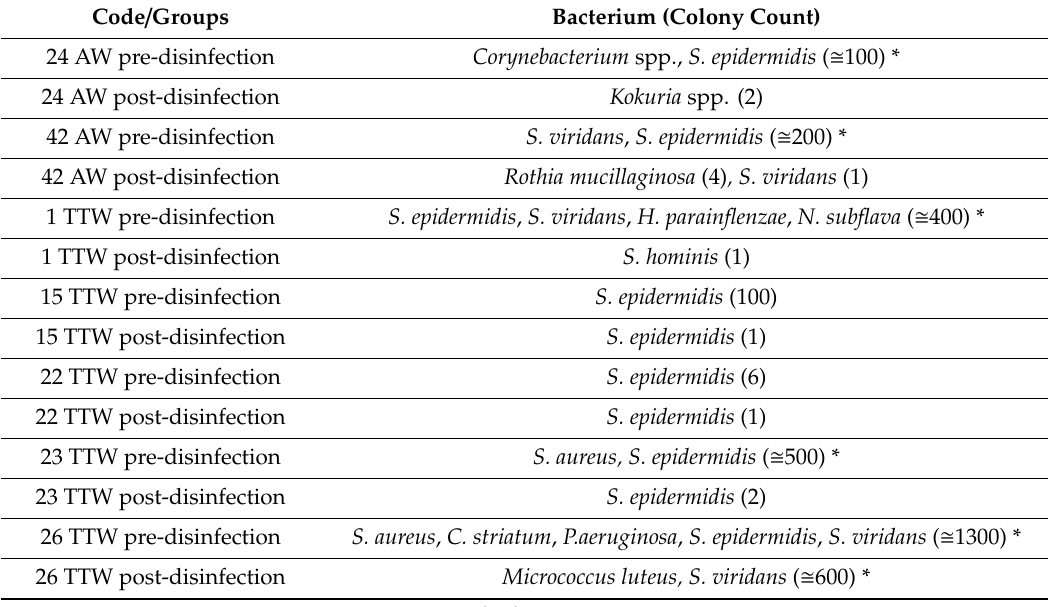
Table 3. Culture results of 7 positive